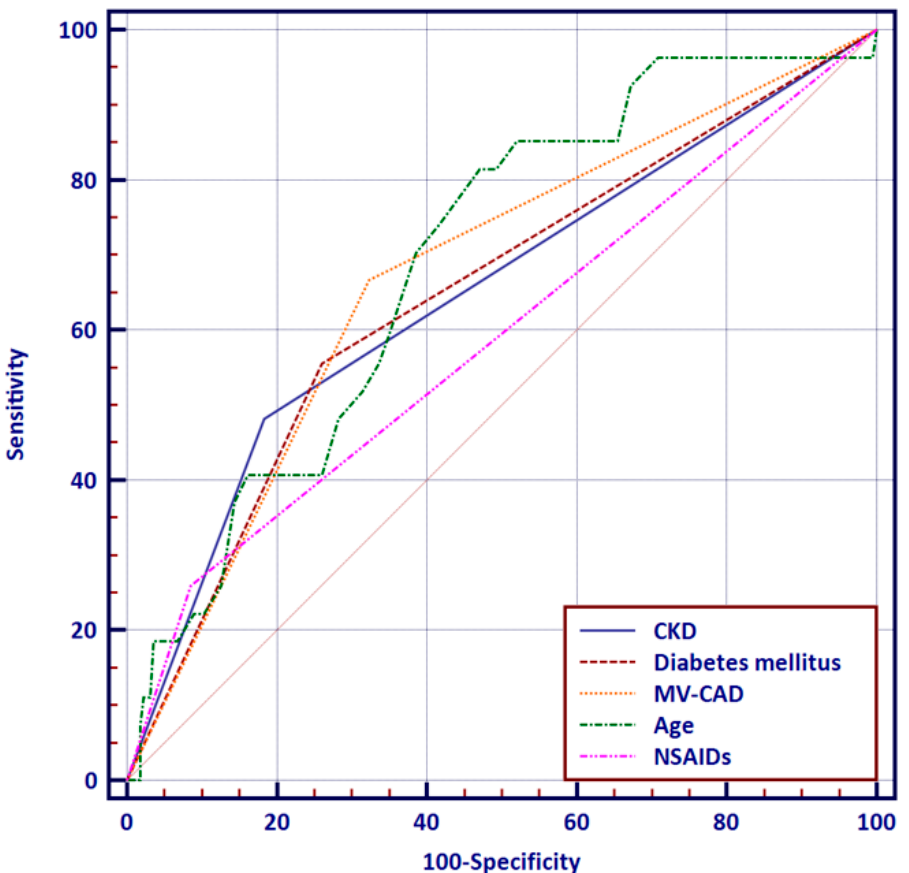
Figure 2. Receiver operating characteristic curve of independent predictors of CI-AKI onset. CKD— chronic kidney disease; MV-CAD—multivessel coronary artery disease; NSAIDs—non-steroidal anti-inflammatory drugs.